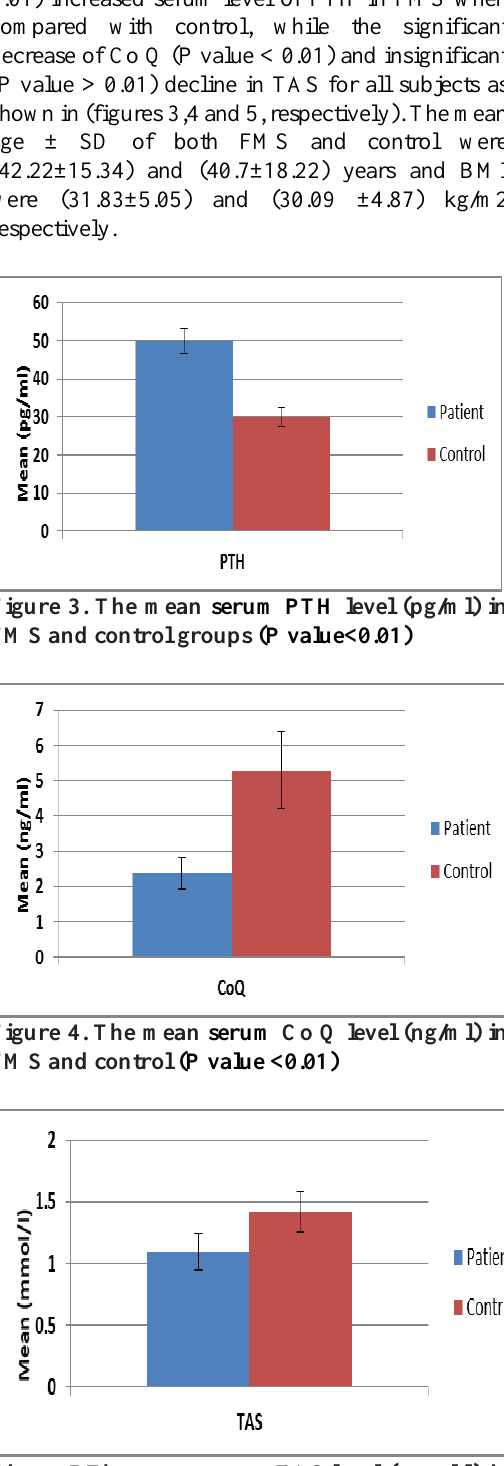
Figure 5.The mean serum TAS level (mmol/l) in both FMS and control groups (P value >